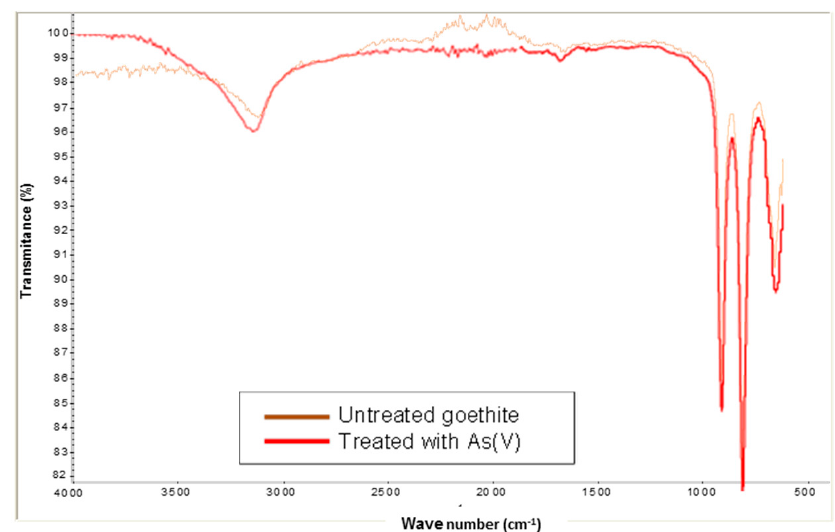
Figure 3. FTIR spectrum of silica sand coated with Fe(III) in absence and presence of As(V).